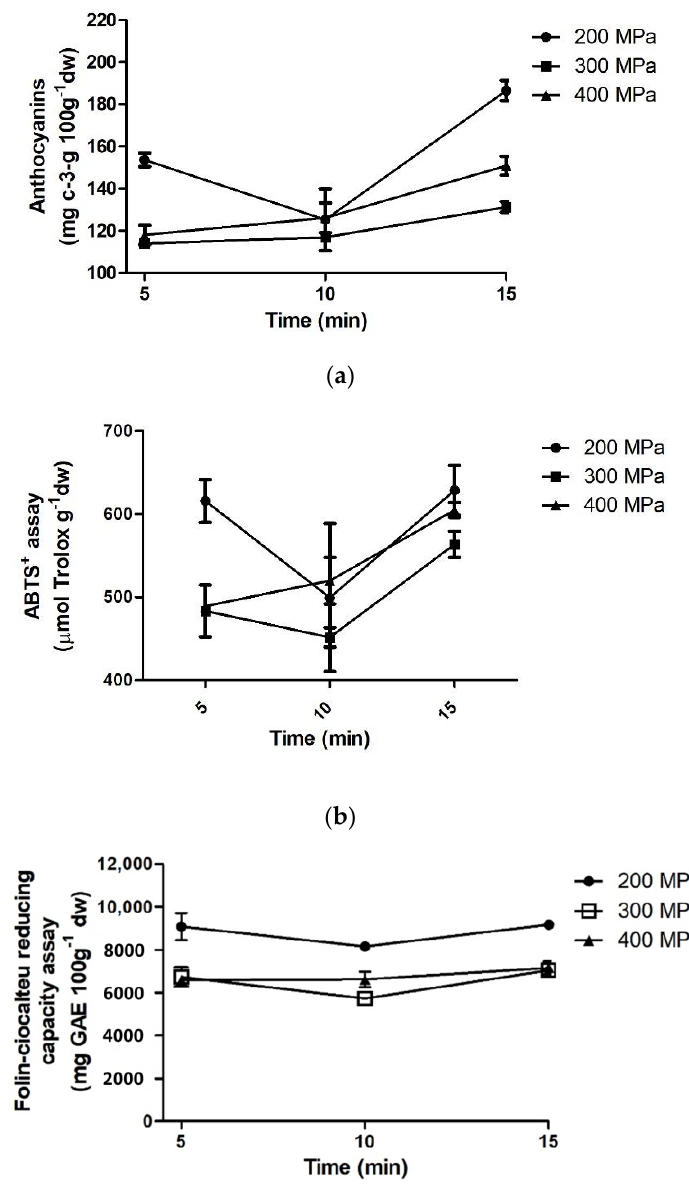
Figure 5. Total monomeric anthocyanins content ( a ), ABTS+ ( b ), and Folin – Ciocalteu reducing capacity ( c ) from jaboticaba skin extracted by HHE.